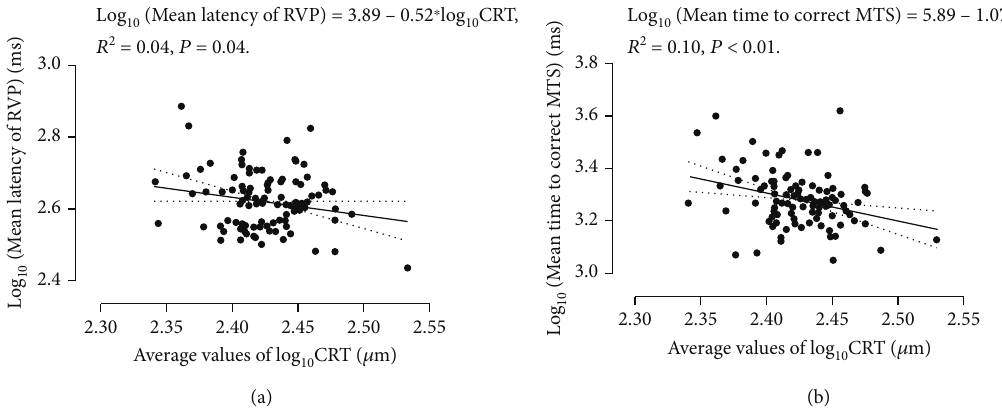
Figure 1: Regression analyses showed the signi fi cantly negative correlations between the average values of CRT and (a) mean latency of RVP test and (b) mean time to correct MTS